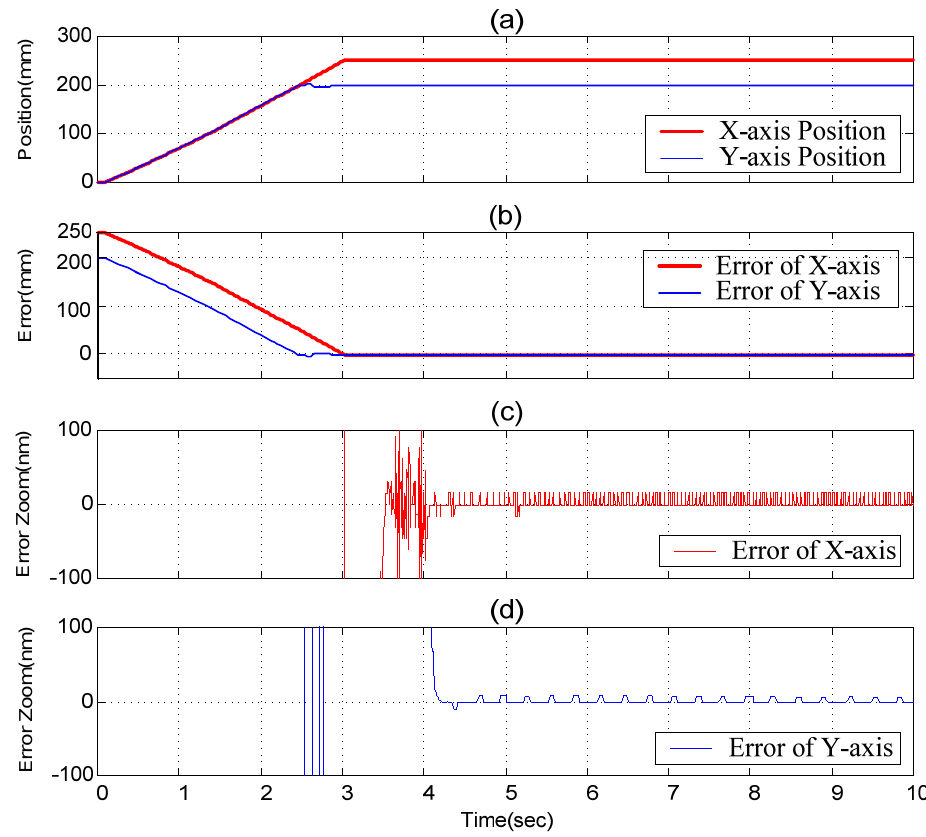
Figure 12. Experimental results of the positioning control of XY dual-axial pneumatic- piezoelectric hybrid actuators by DSOFSMC without X-Y decoupling compensator: strokes of (X,Y)= (250 mm, 200 mm), (a) position control response of X- and Y-axes.